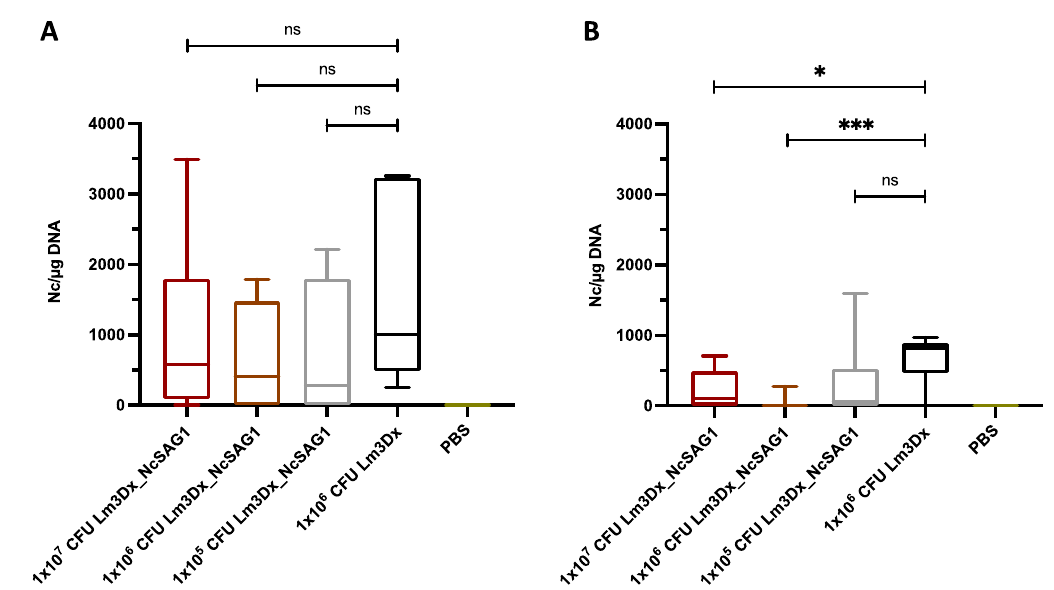
dam groups compared to the positive control (Figure 3A).